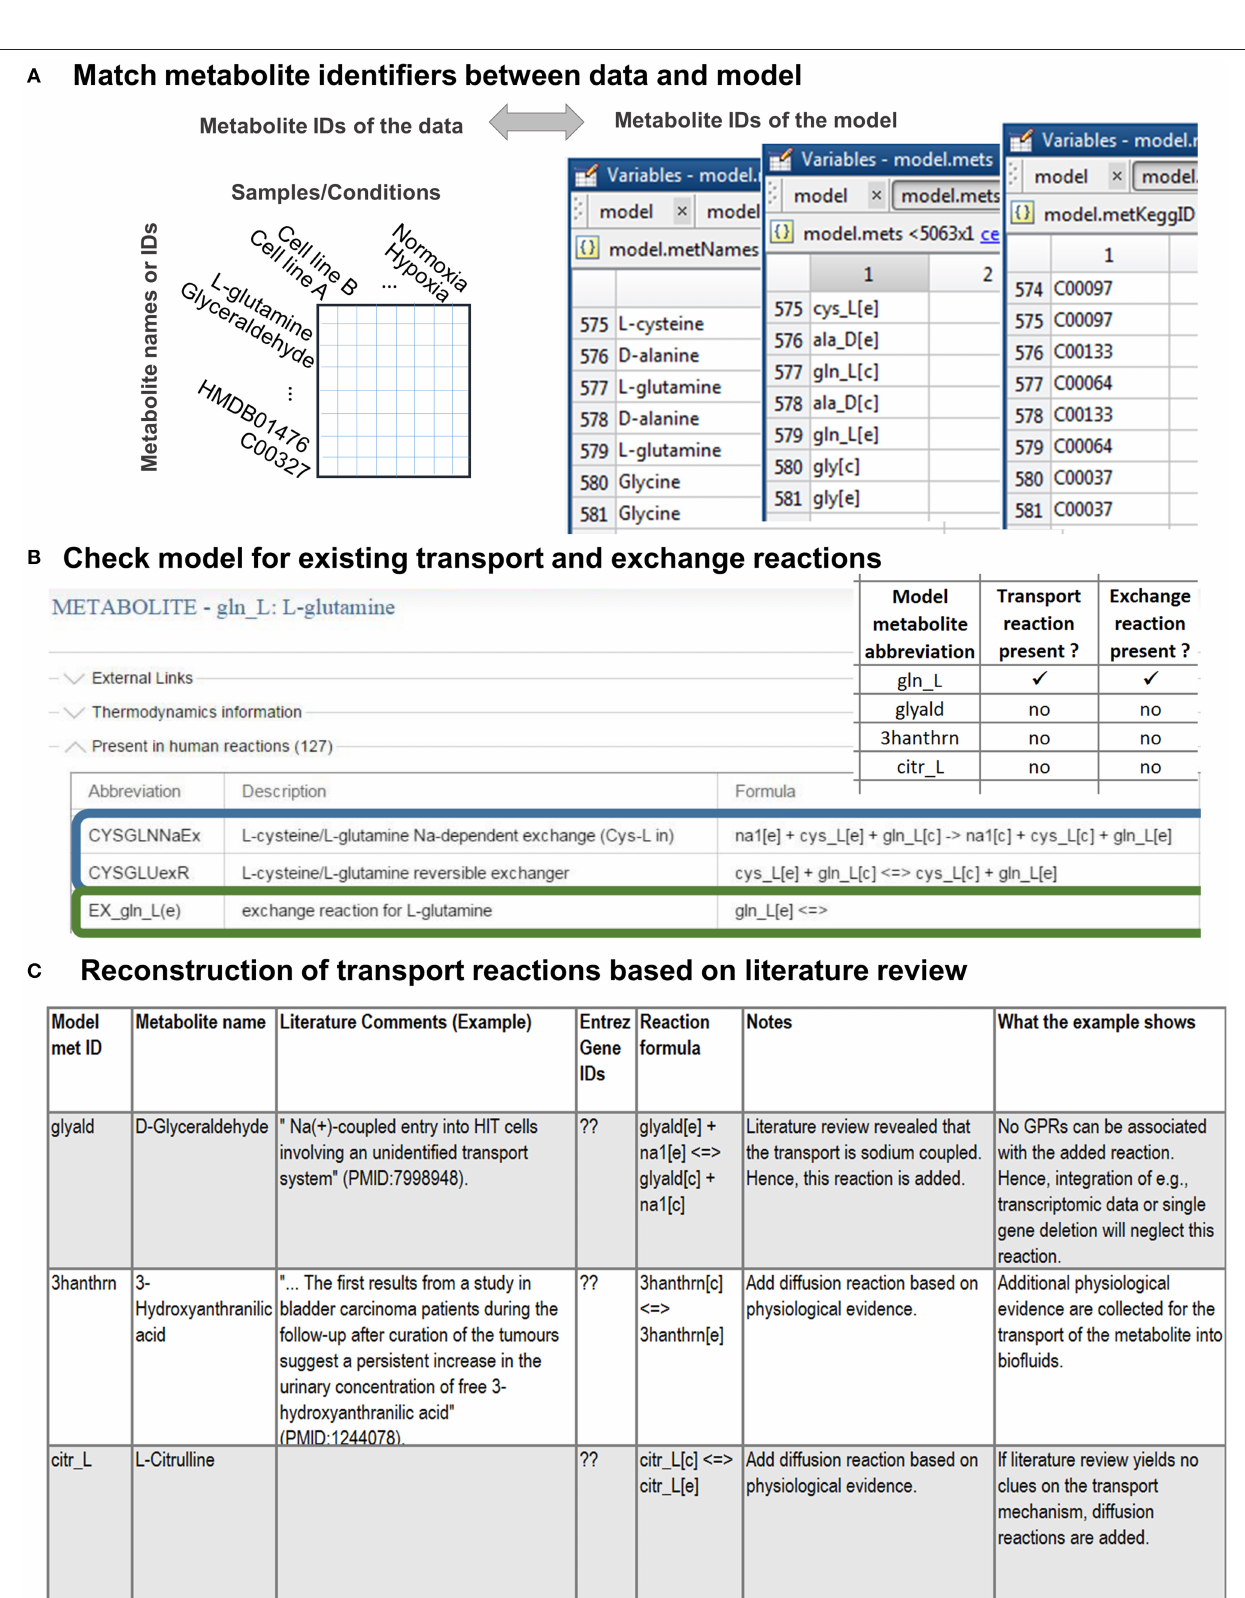
Frontiers in Physiology | www.frontiersin.org 5 August 2016 | Volume 7 | Article